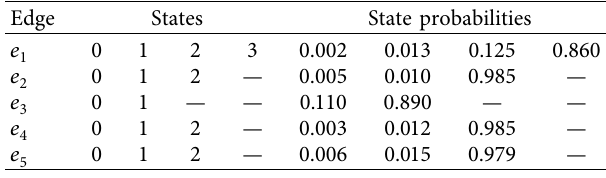
Figure 2: The bridge network. Table 1: The data of edges for the bridge network in Figure